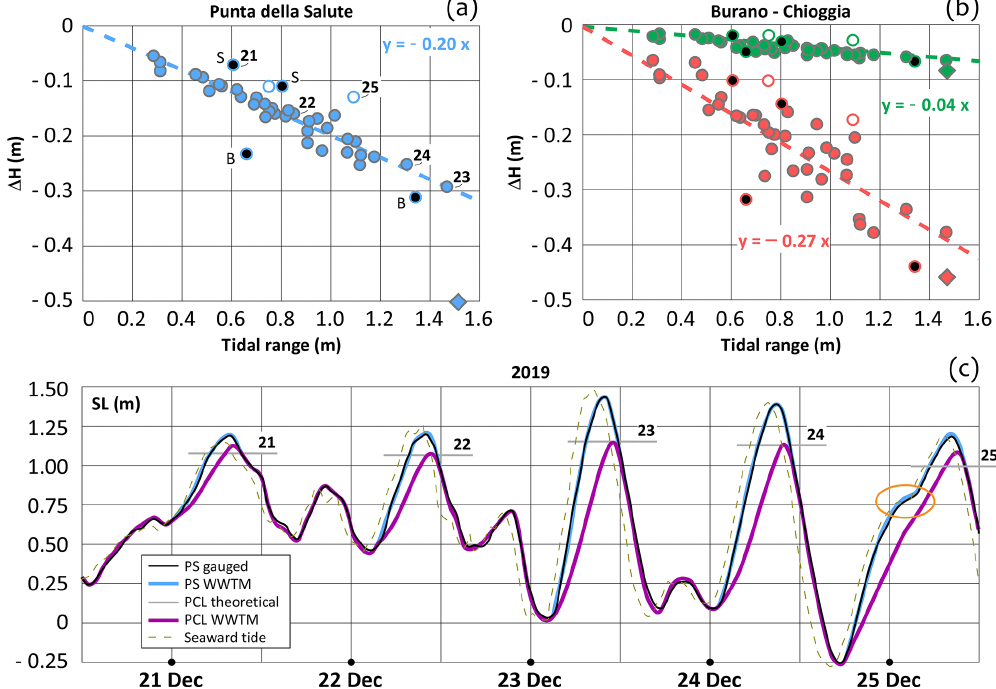
Figure 5. Dataset 2019–2020. SL peaks ≥ 1.10m at PS (or at the CNR platform during the tests performed at the Mo.S.E. barriers since October 2020). Relationship between tidal range and (cid:49)H at (a) Punta della Salute (blue), (b) Burano (red), and Chioggia (green). Black bullets indicate the events characterized by strong Bora (B) or Sirocco (S), white bullets are the events when two tidal cycles were merged due to a prominent seiche wave in the Adriatic Sea, and rhombus is the event of 12 November 2019. (c) Time series 21–25 December 2019 at PS. SL observed (black line) and computed by means of the hydrodynamical model (PCL, purple; unregulated condition, blue). SLs computed at the peak by Eq. (1) are represented by the horizontal grey lines and mean gauged seaward SL by the grey dashed